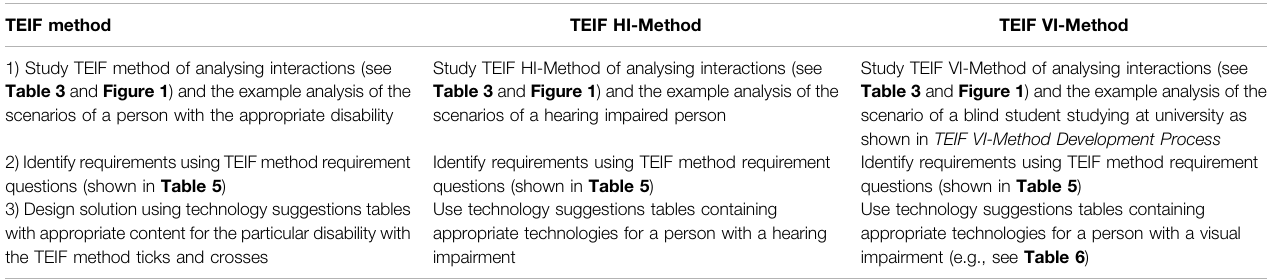
TABLE 4 | How the TEIF HI-Method and TEIF VI-Method relate to a general TEIF